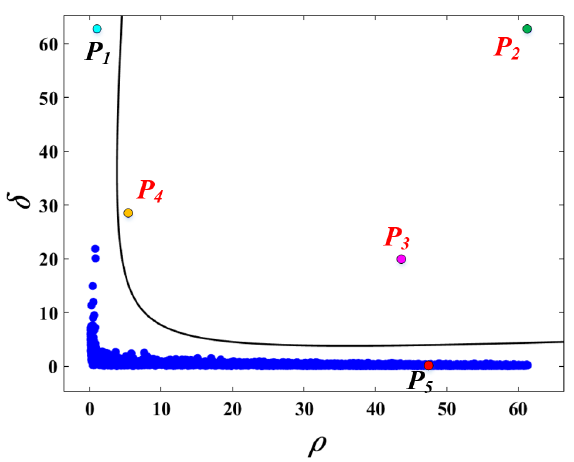
Figure 6. Separate Function Decision Graph. The letters of final cluster centers are marked by red color.